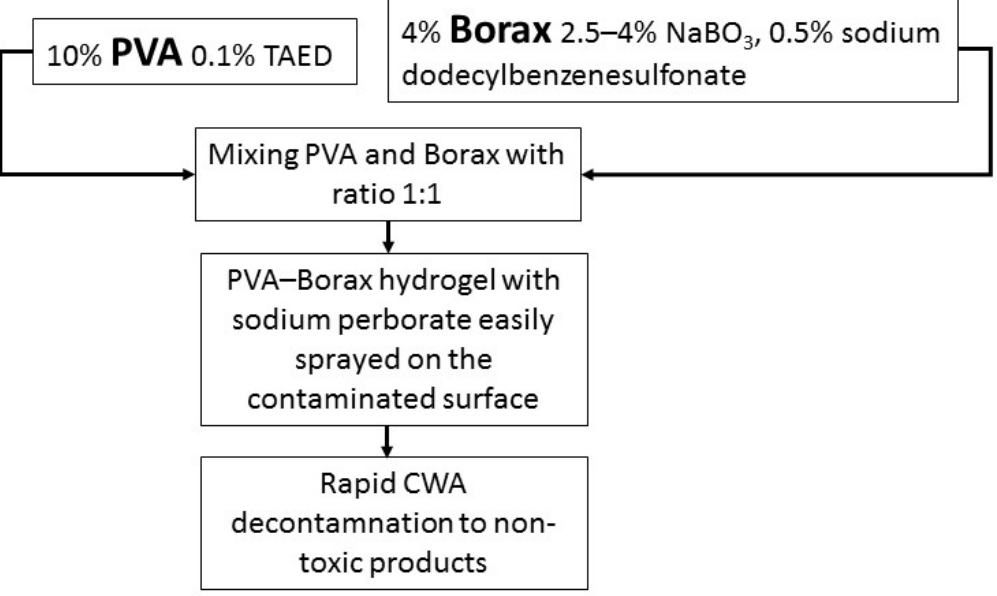
Figure 4. Scheme of neutralization and treatment after VX contamination with PVA-Borax hydrogel. (PVA—polyvinyl alcohol, TAED—tetraacetyl ethylenediamine, Borax—sodium tetraborate) [62].